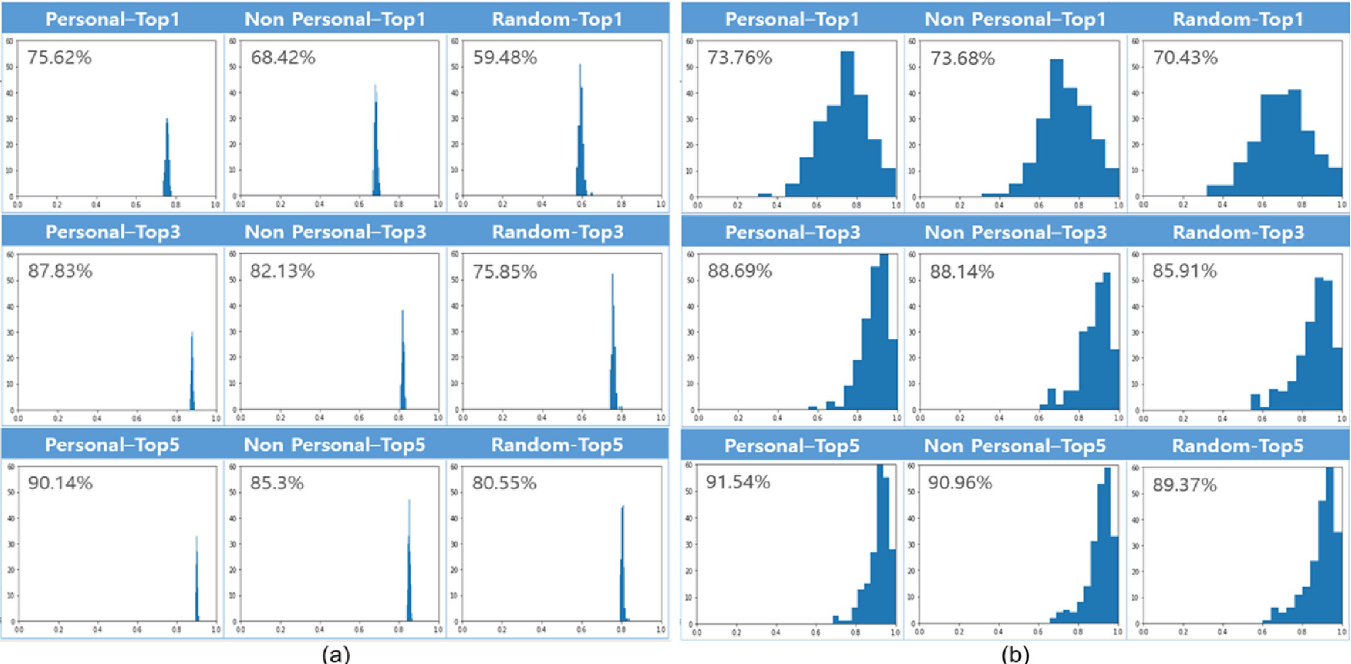
Fig 6. Prediction results using (a) random clustering and (b) mobility pattern clustering. We also present the prediction results for different embedding methods.